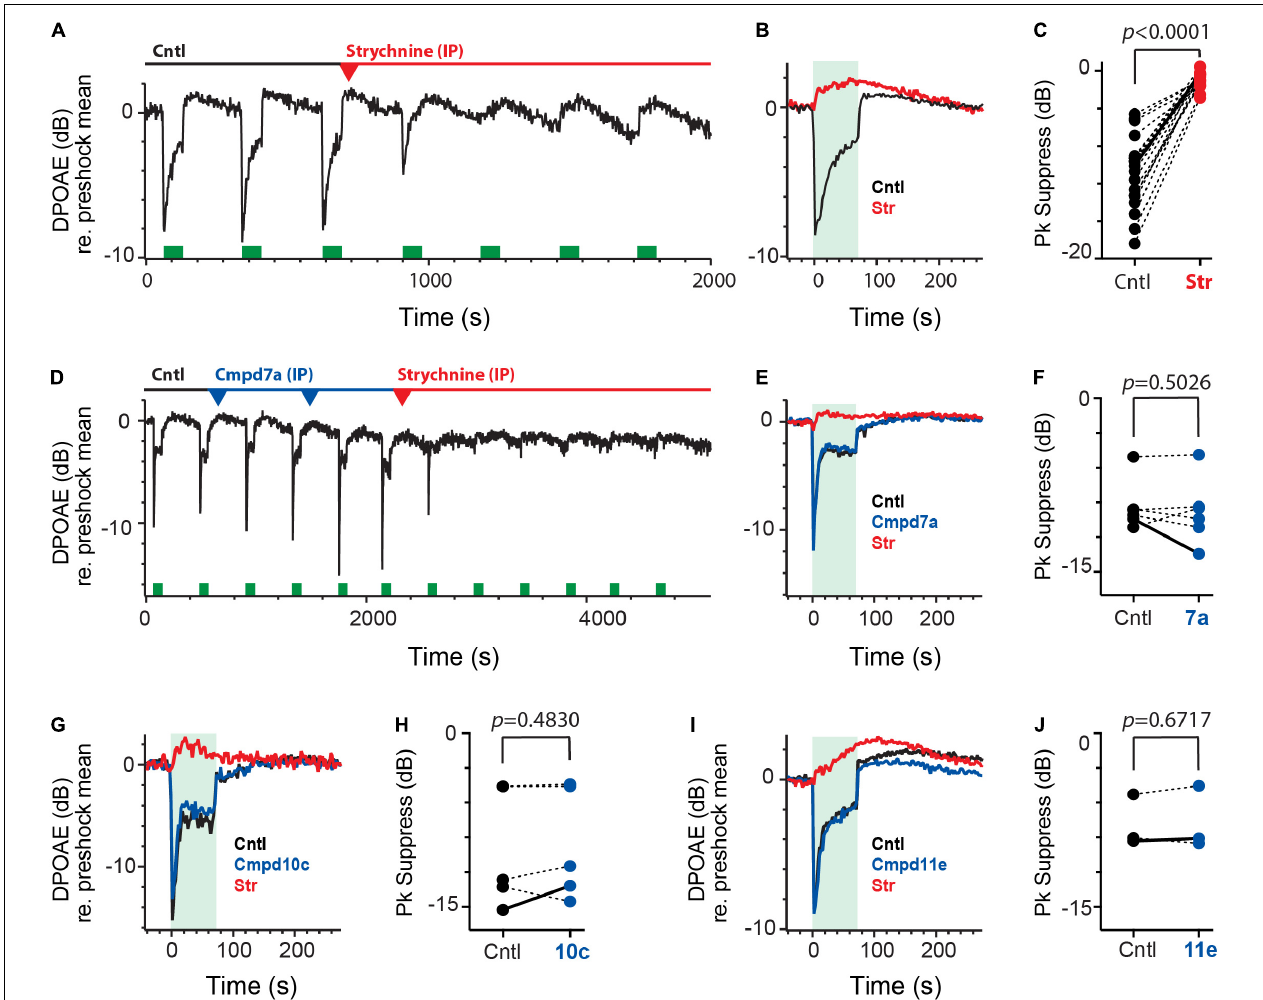
FIGURE 6 | Intraperitoneal administration of charged α 9 α 10nAChR blockers fail to block efferent-mediated suppression of mice DPOAEs. (A) Continuous recording of mouse DPOAEs during midline stimulation of MOC efferent neurons (green bars, 200 shock/s for 70 s), before (Cntl) and after IP administration of strychnine at t = 700 s. (red arrowhead, 6 mg/kg). (B) Mean responses, from (A) , showing the effect of midline efferent stimulation (70-s duration @ 200 shocks/s, green box) on DPOAE amplitude before (Cntl, black trace) and after IP administration of strychnine (Str, red). (C) Peak values of efferent-mediated DPOAE suppression (Pk Suppress) are plotted for multiple animals before (Cntl, black) and after the application of strychnine (Str, red). Solid line shows values from mean traces in (B) . (D) Continuous recording of mouse DPOAEs during midline stimulation of MOC efferent neurons (green bars, 200 shock/s for 70 s), before (Cntl) and after two IP doses of Cmpd7a (2.5 mg/kg each, blue arrowheads) and subsequent IP strychnine (6 mg/kg, red arrowhead). (E) Mean responses, from (D) , showing the effect of midline efferent stimulation (70-s duration @ 200 shocks/s, green box) on DPOAE amplitude before (Cntl, black trace) and after IP delivery of Cmpd7a (blue trace) and then strychnine (red trace). (F,H,J) Peak values of efferent-mediated DPOAE suppression (Pk Suppress) are plotted for multiple animals before (Cntl, black) and after the application of Cmpd7a, 10c, or 11e (blue). Solid line shows values from corresponding traces in (E,G,I) . (G,I) Mean responses showing the effect of